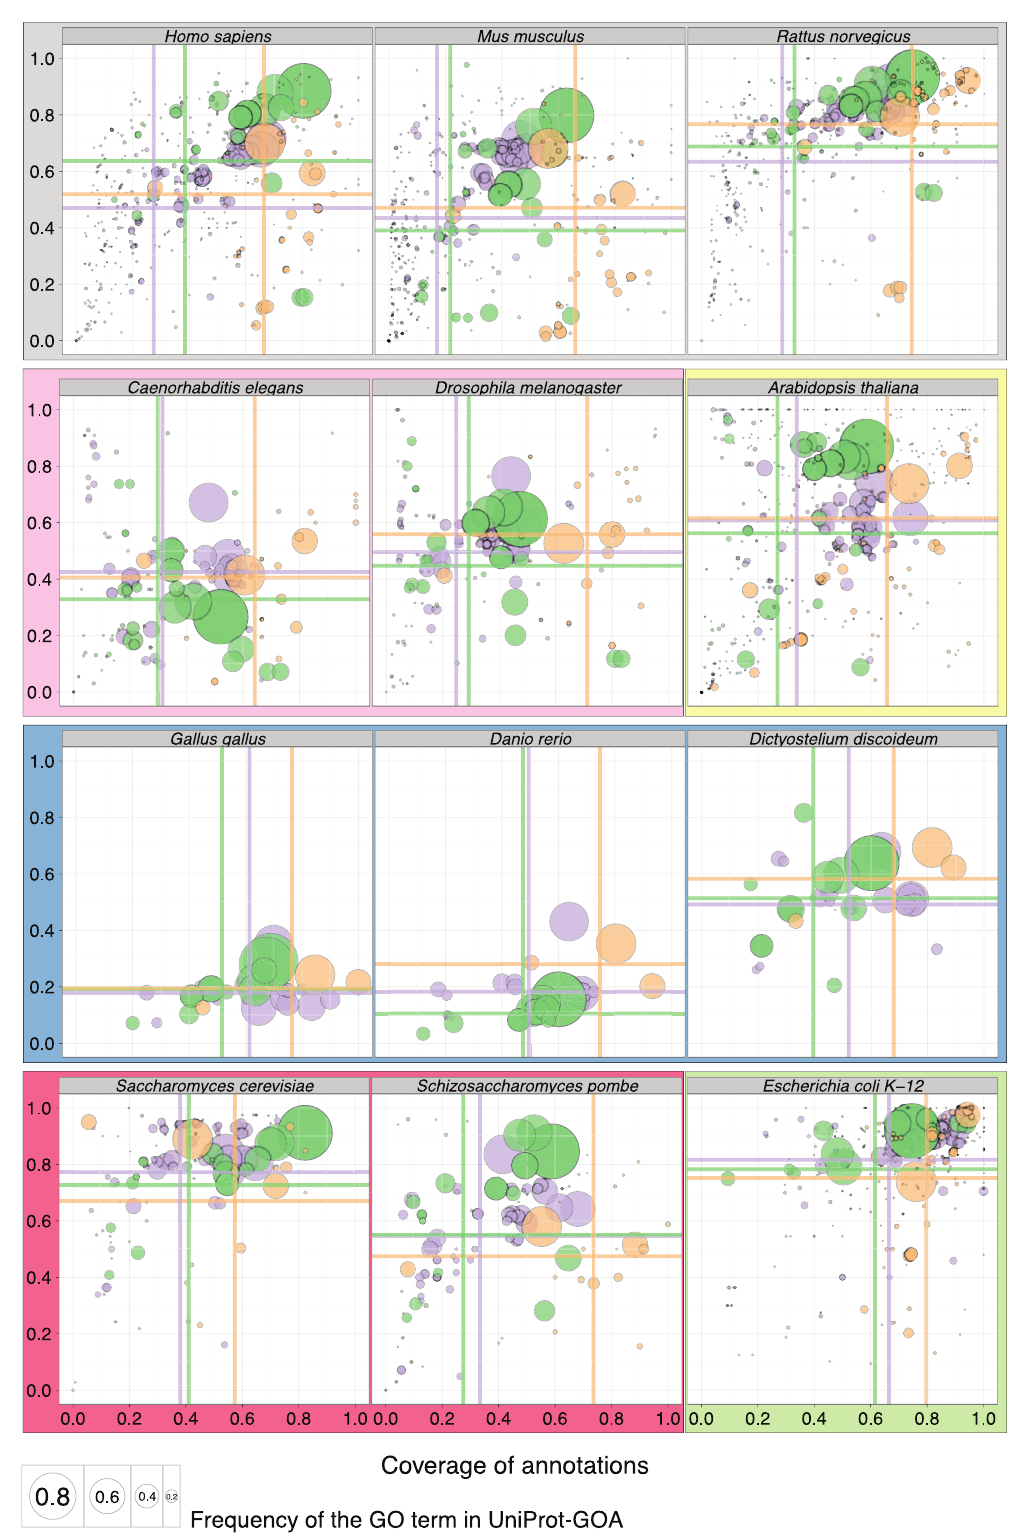
Figure 7. Quality of the 16-01-2008 UniProt-GOA release, evaluated by the 11-01-2011 UniProt-GOA release; each model organism is evaluated separately. Common background shading denotes a depiction of the same set of GO terms (full data is presented in Fig. S8 in Text S1). The ontology is denoted by the color of the disc, while the area of the disc reflects the frequency of the GO term in the 16-01-2008